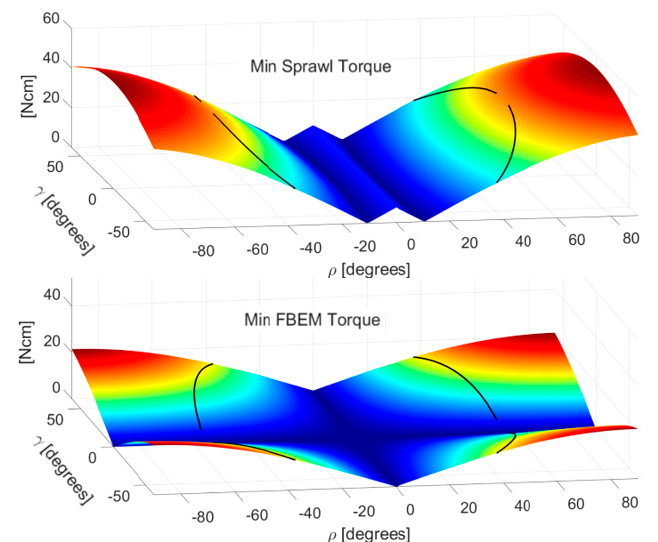
Figure 10. The torques that must be applied by the sprawl and four bar extension mechanism (FBEM) joints to maintain a normal force of 4.9 N to the walls to climb vertically.